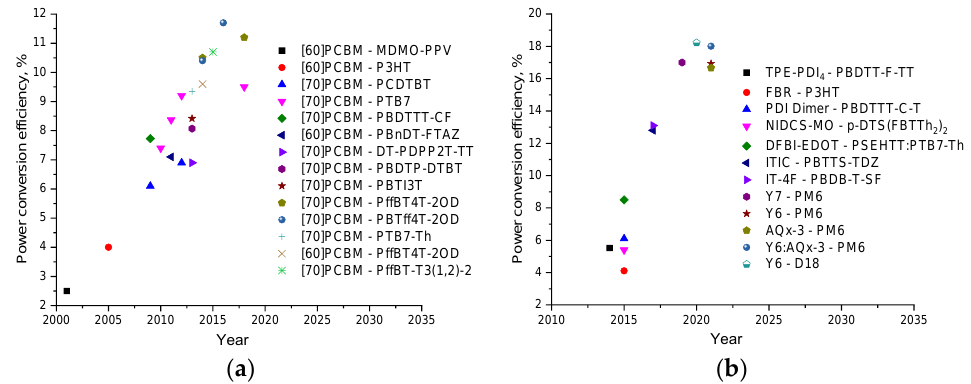
Figure 7. Evolution of organic solar cells with ( a ) fullerene- and ( b ) non-fullerene acceptor materials. A further increase in the efficiency of OSCs up to the current ~18% has mainly been associated with the development of new non-fullerene acceptor (NFA) materials with tailored properties. To date, it has been possible to produce OSCs with PCE going beyond 18% using such NFAs as Y6 and AQx-3 [10,63]. Figure 8 shows the molecular structures of some NFAs that have proven to be promising n-type semiconductor materials for the high-efficiency OSCs [64–71].